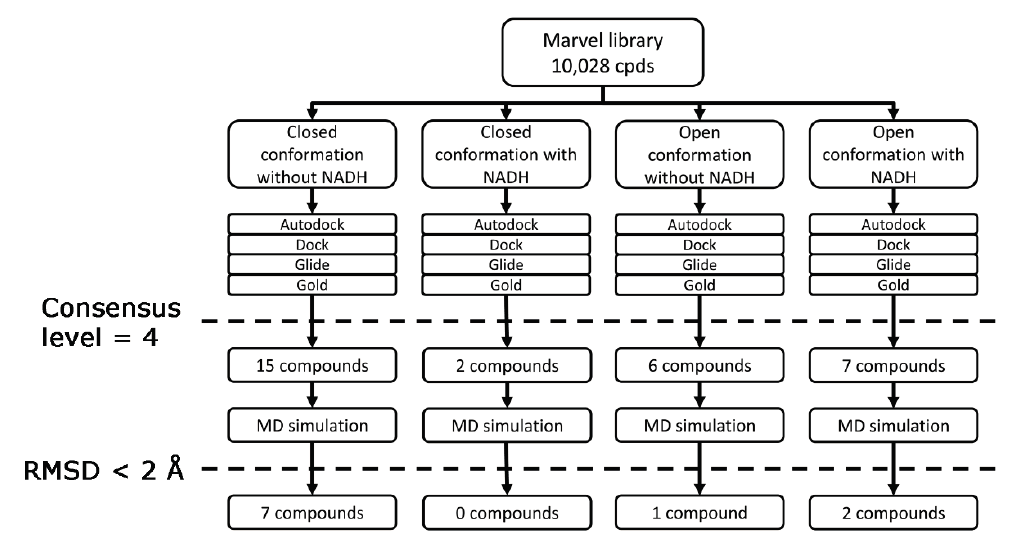
Figure 3. Schematic diagram of the virtual screening